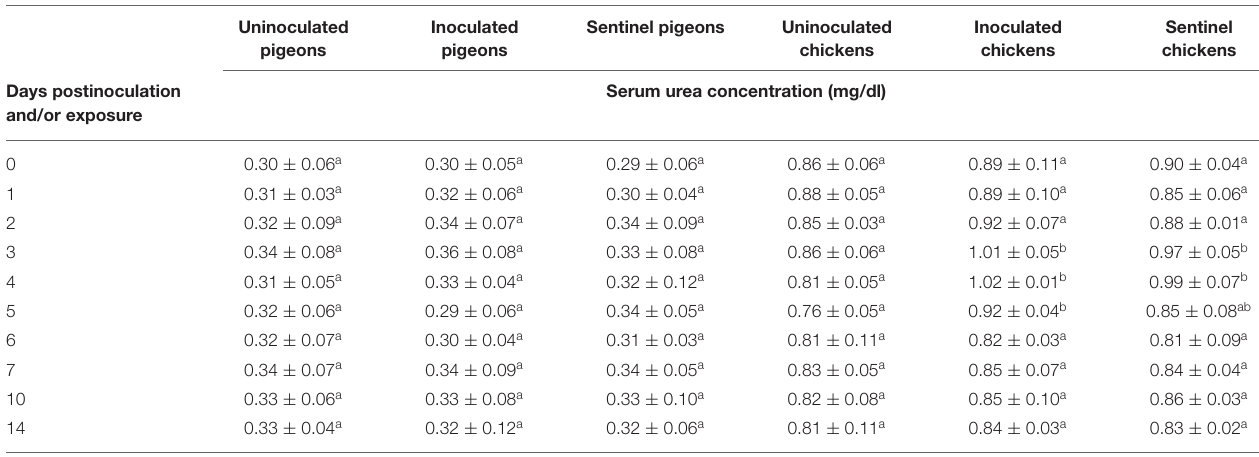
TABLE 11 | Mean serum urea concentration of pigeons and chickens following inoculation with and/or exposure to a very virulent infectious bursal disease virus.